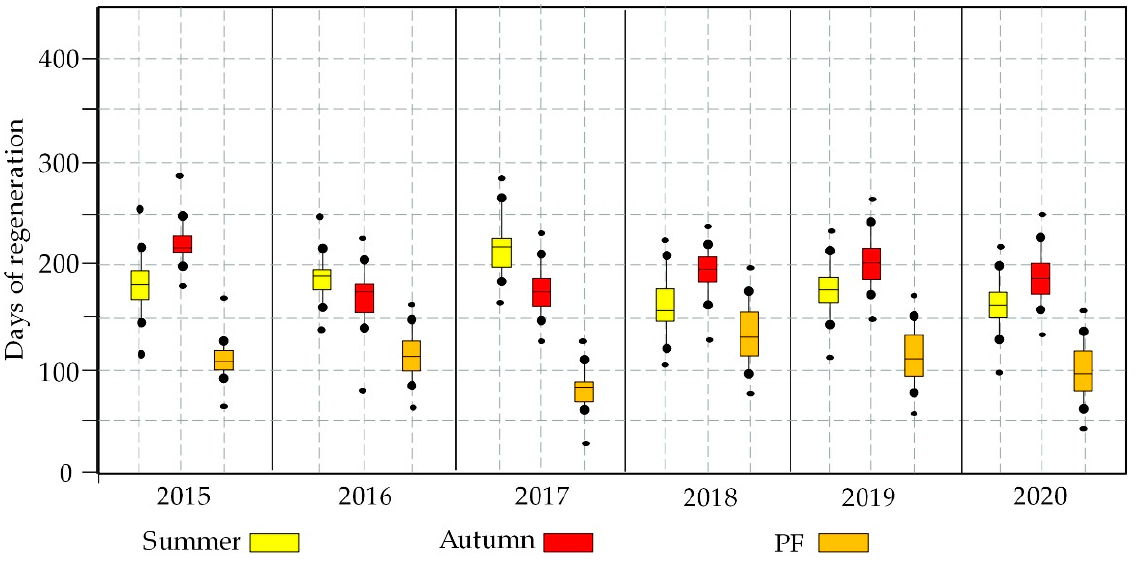
Figure 3. Analysis of days for vegetation recovery from fire using NDVI. Figure 4 indicates that the average pre- and post-fire NDVI differences for autumn wildfires, summer wildfires, and prescribed fires were 0.398, 0.278, and 0.156, respec- tively. The T-K test revealed that the severity of the autumn wildfires was not statistically different from that of the prescribed fires. Summer wildfires, however, differed consider- ably in severity from prescribed fires, but the difference between summer and autumn wildfires was not found to be statistically significant.